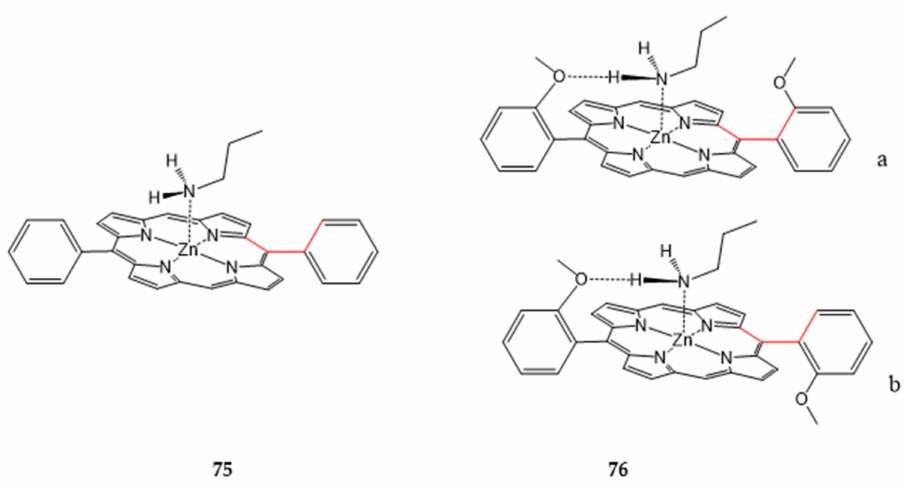
Figure 16. Complexes of porphyrinate 75 and atropoisomers ( a , b ) of porphyrinate 76 with PrA.